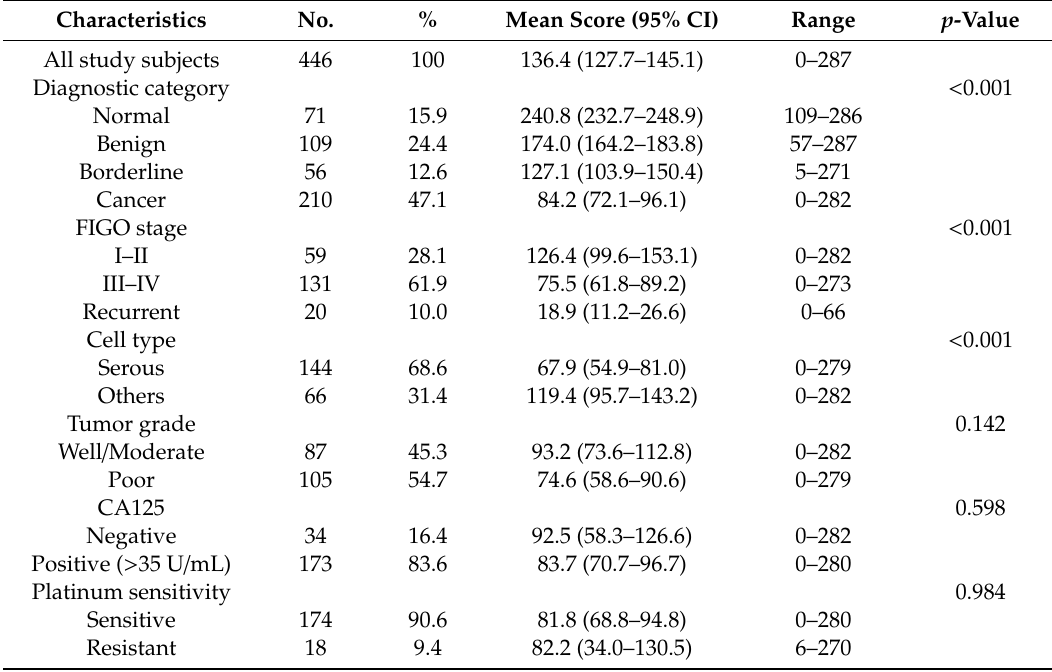
FIGO, International Federation of Gynecology and Obstetrics; CA125, cancer antigen 125; CI, confidence